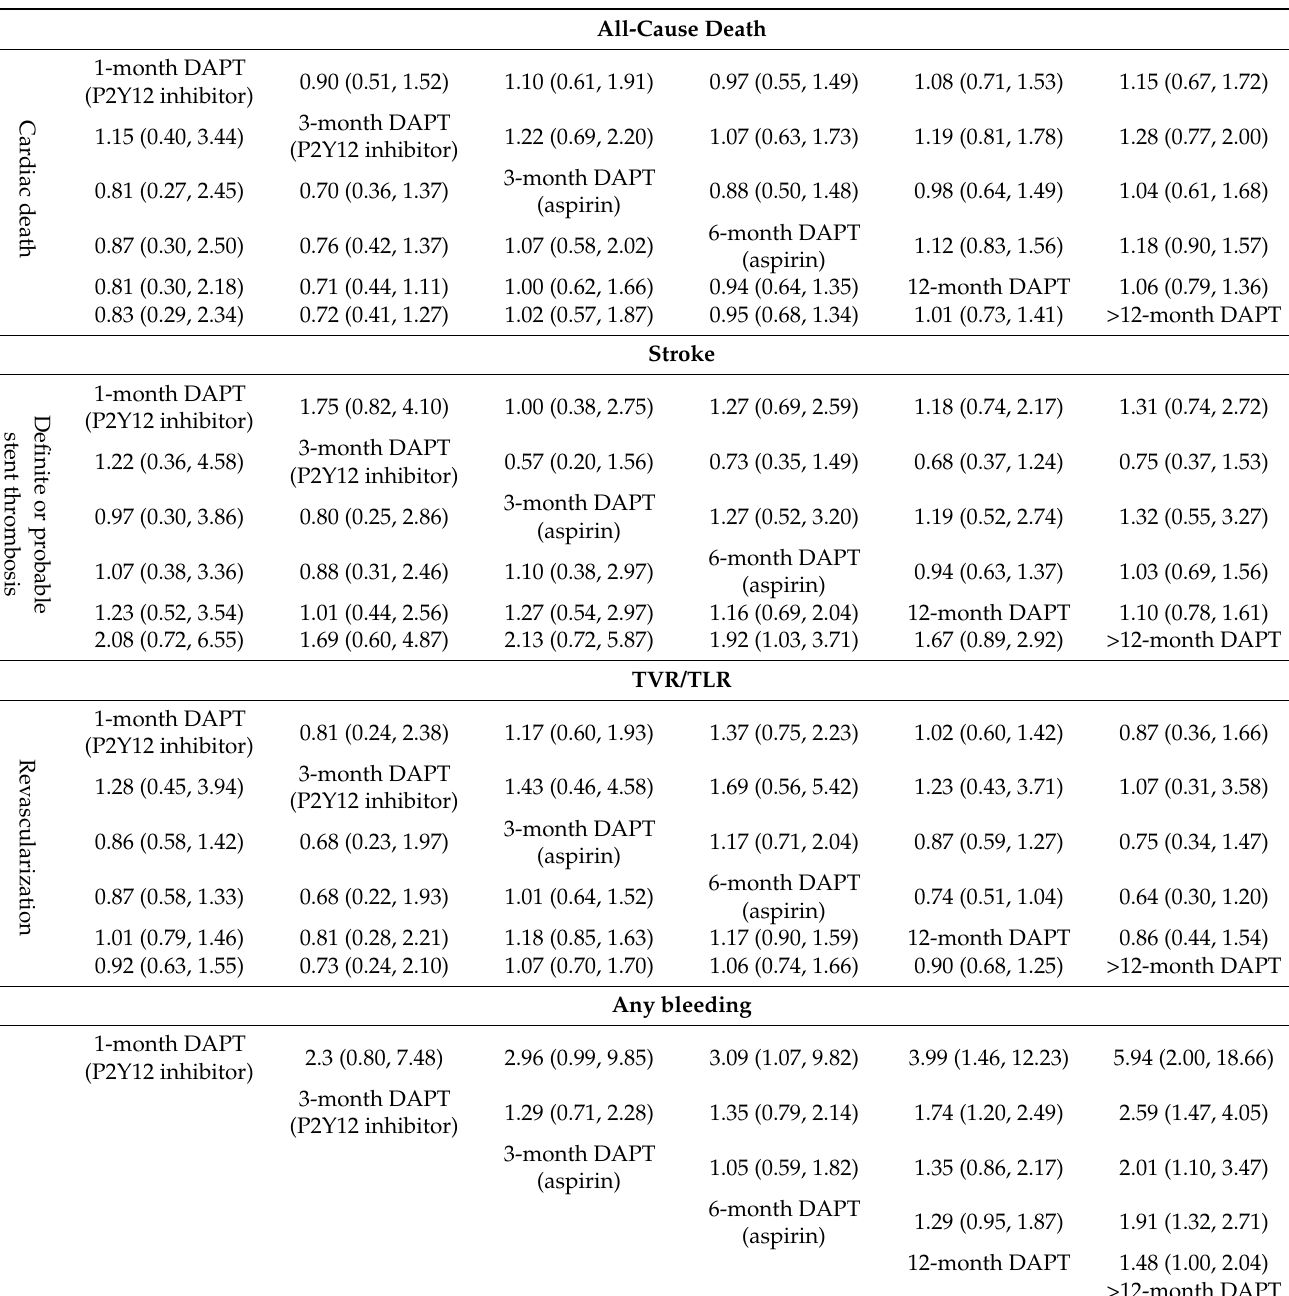
Table 2. Comparisons for Secondary Outcomes of All DAPT Strategies. All-Cause